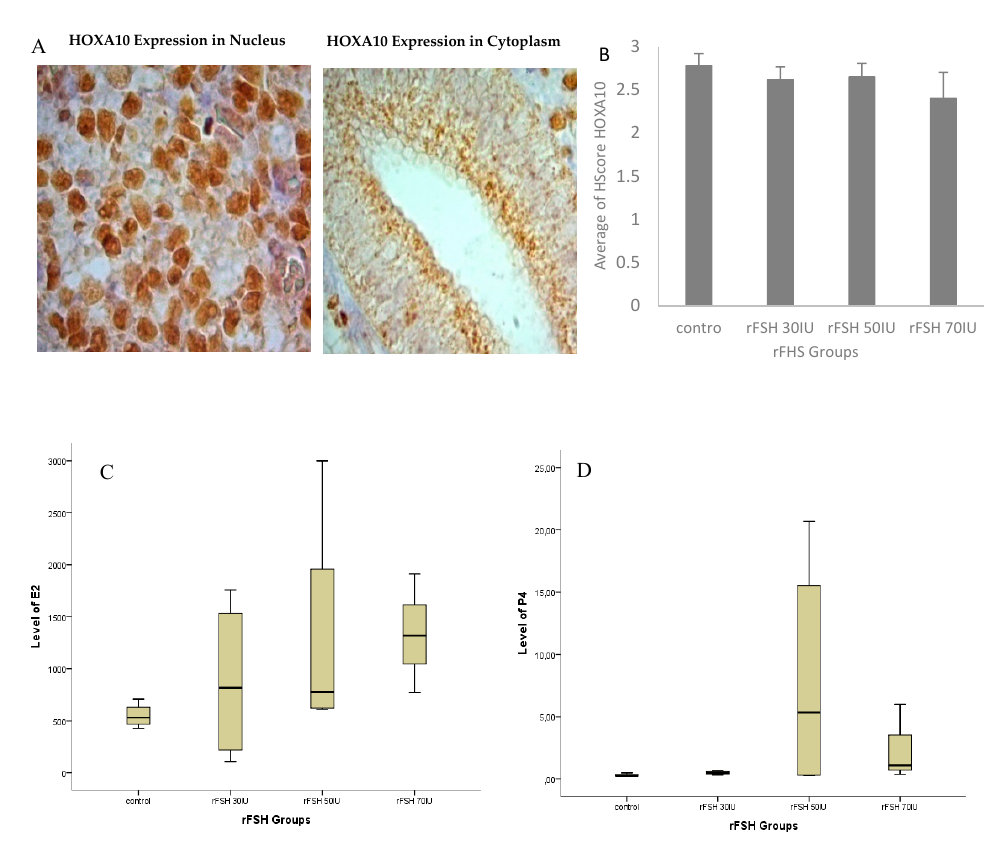
Figure 2. Immunohistochemical localization of homeobox A10 (HOXA10) protein in Macaca nemestrina endometrium. Localization of HOXA10 expression in cytoplasmic gland epithelium cells and nucleated stroma cells in 1000 × magnification ( A ). Using ANOVA Average of Hscore HOXA10 in nucleated stroma cells found not statistically significant within groups ( p -value, 0.126) ( B ); levels of E2 ( C )